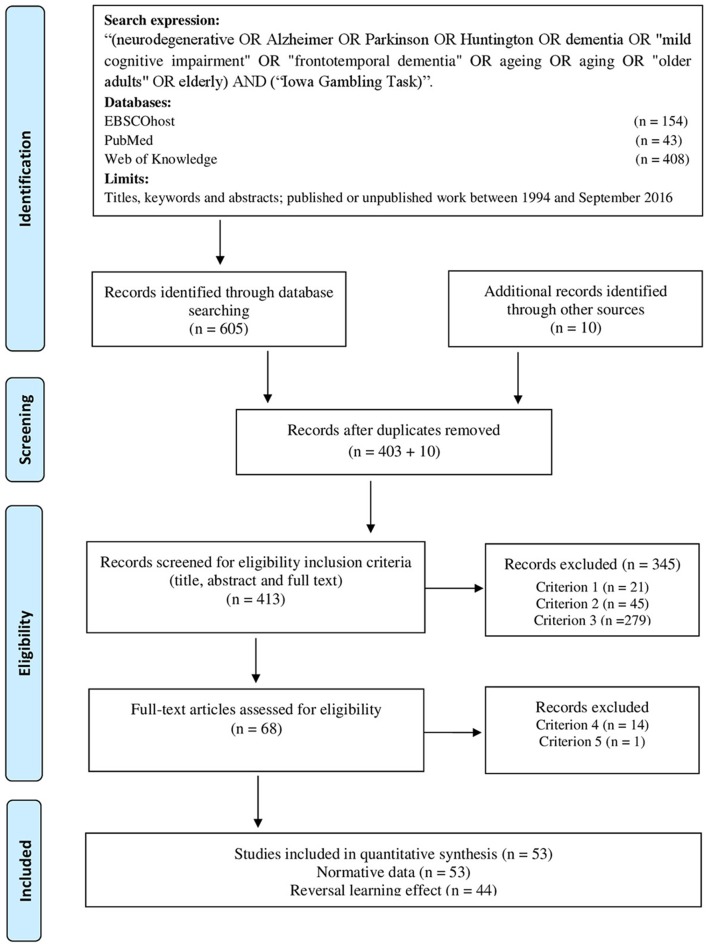
PRISMA flow diagram.